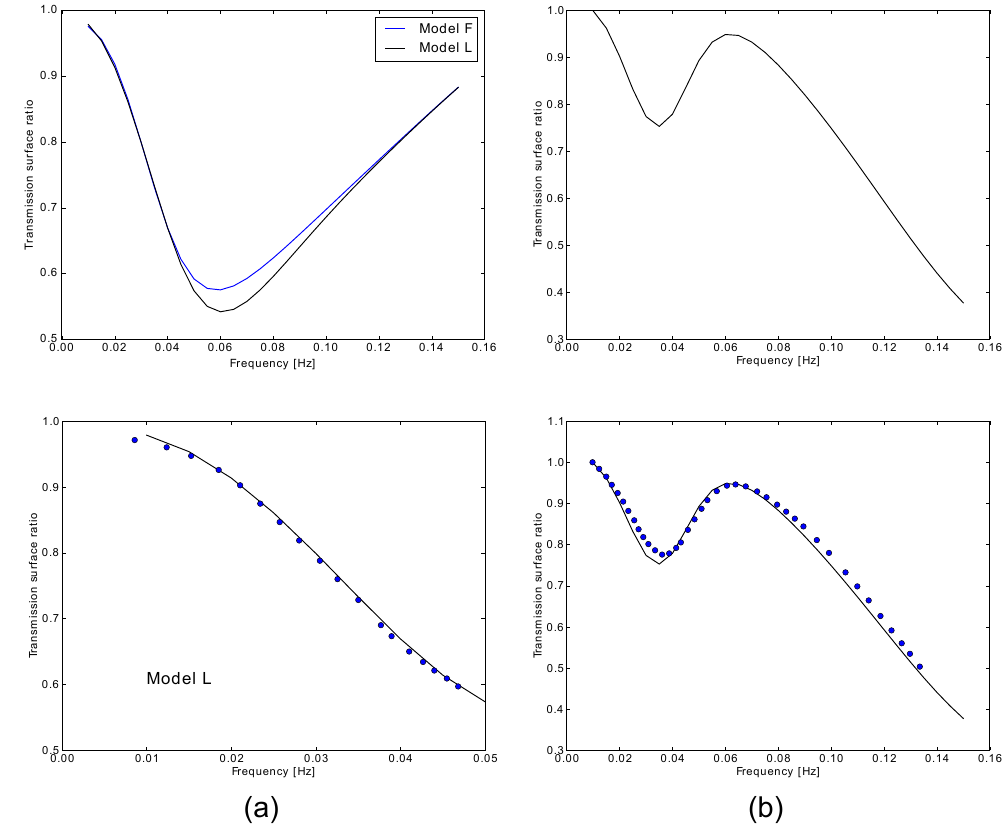
Figure B2. Rayleigh wave fundamental mode transmission surface ratios for two types of models taken from ItsYan85: (a) models “F” and “L”, same as for Fig. B1, and (b) the deep fault model, Fig. 10 of ItsYan85. In both cases the top panel shows the SWRT results; the bottom panel compares these (lines) with manually digitized values (circles) obtained from Figs. 9 and 11 – for (a) and (b) respectively – of